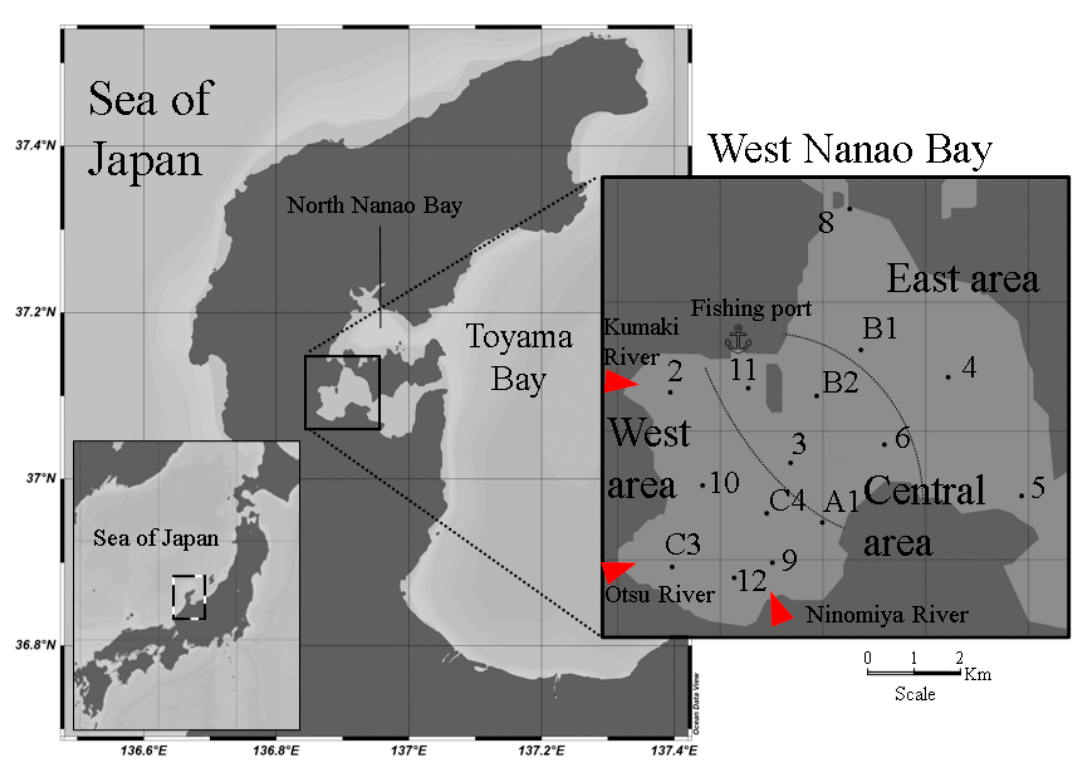
Figure 1. Sampling points at West Nanao Bay, Noto Peninsula, Japan. May 2019–September 2020.